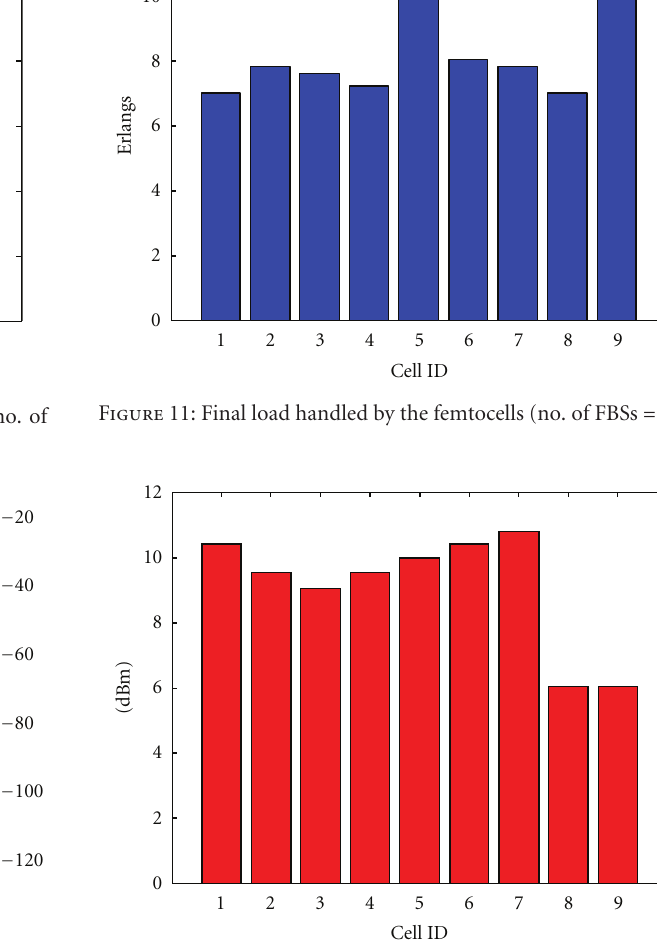
Figure 12: Converged pilot power setting of the femtocells (no. of FBSs = 9).